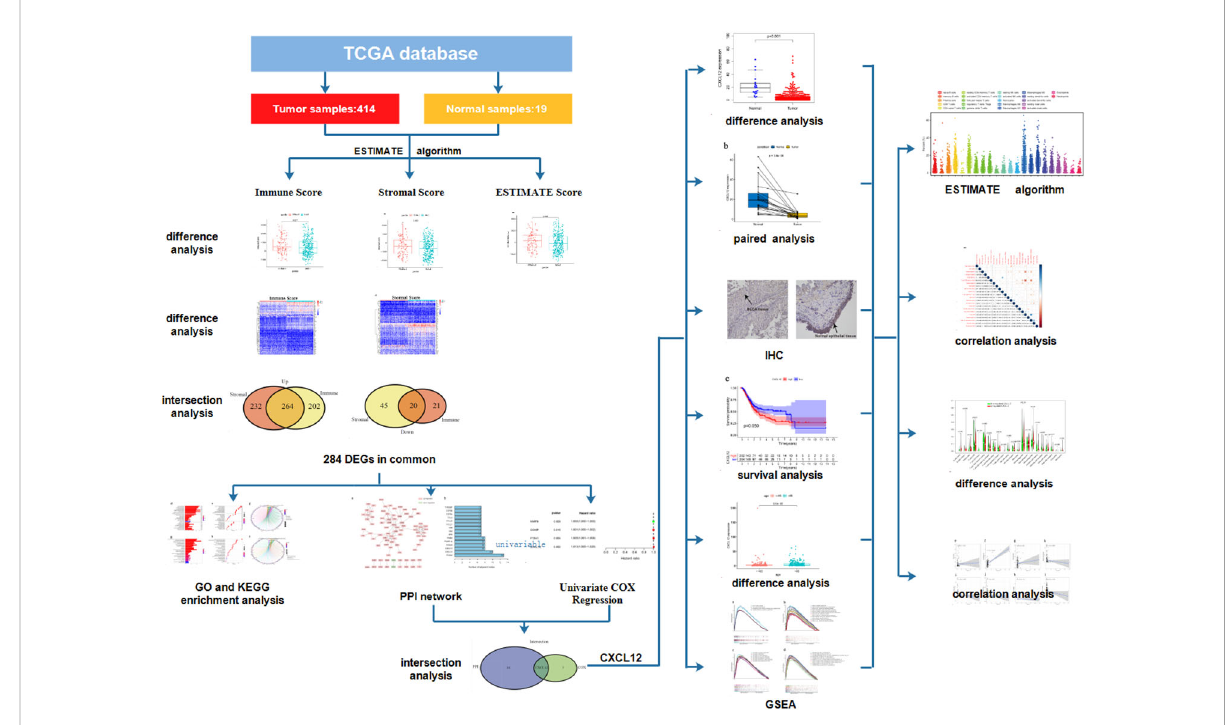
FIGURE 1 The analysis process of the